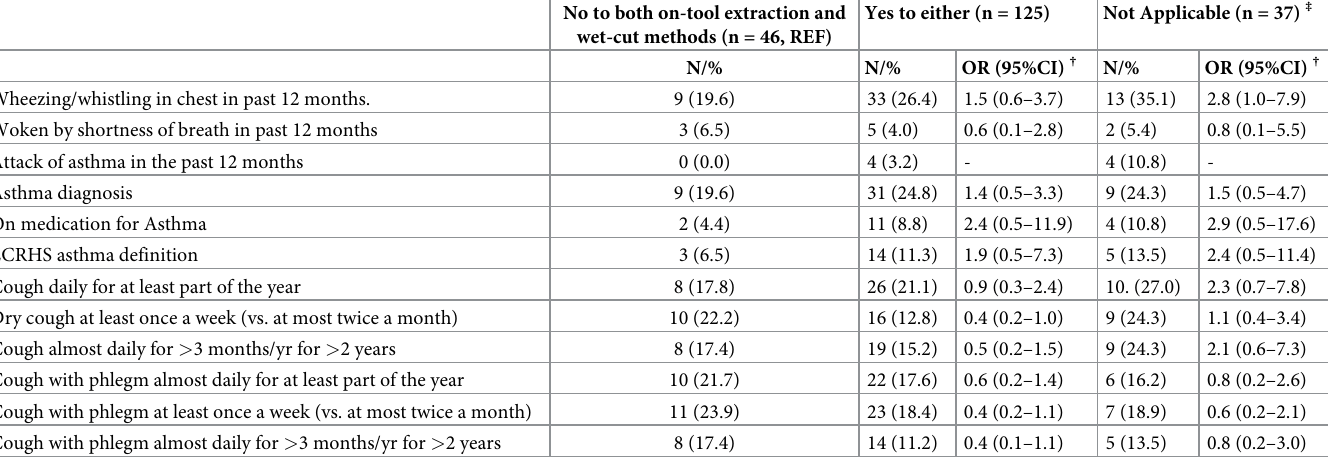
Table 4. Prevalence odds ratios for use of on-tool vacuum extraction and wet-cut systems in construction workers.